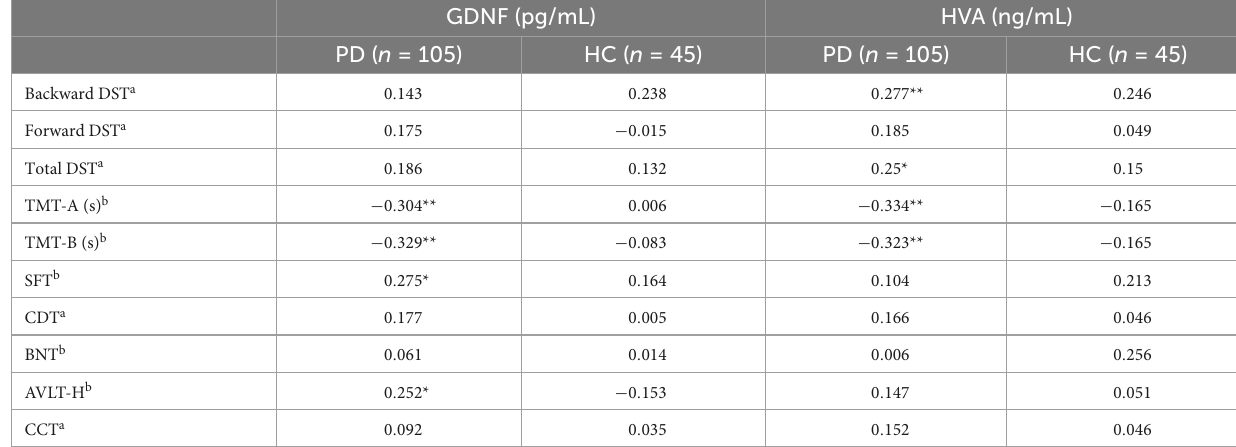
TABLE 3 Relationship between serum glial cell line-derived neurotrophic factor (GDNF) or high vanillic acid (HVA) concentration and neuropsychological tests (correlation coefficient r